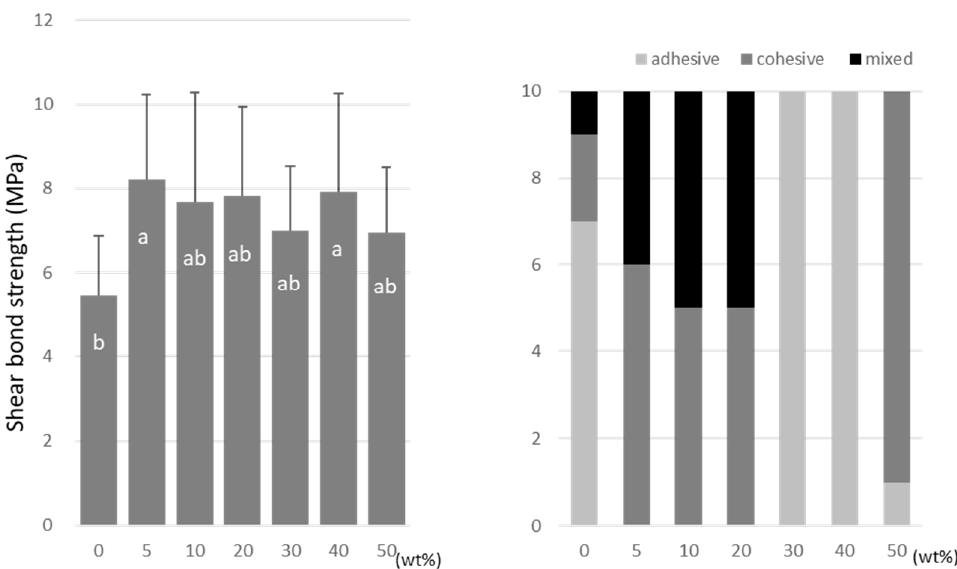
Figure 7. Shear bond strength ( left ) between CAD/CAM PMMA disk and TMPTA. Same letters (a,b) in each column are not significantly different ( p > 0.05). Distribution of failure modes after test ( right ). A-DPH peaked at a 10 wt% doping (8.7 ± 2.2 MPa), and the SBS at 50 wt%